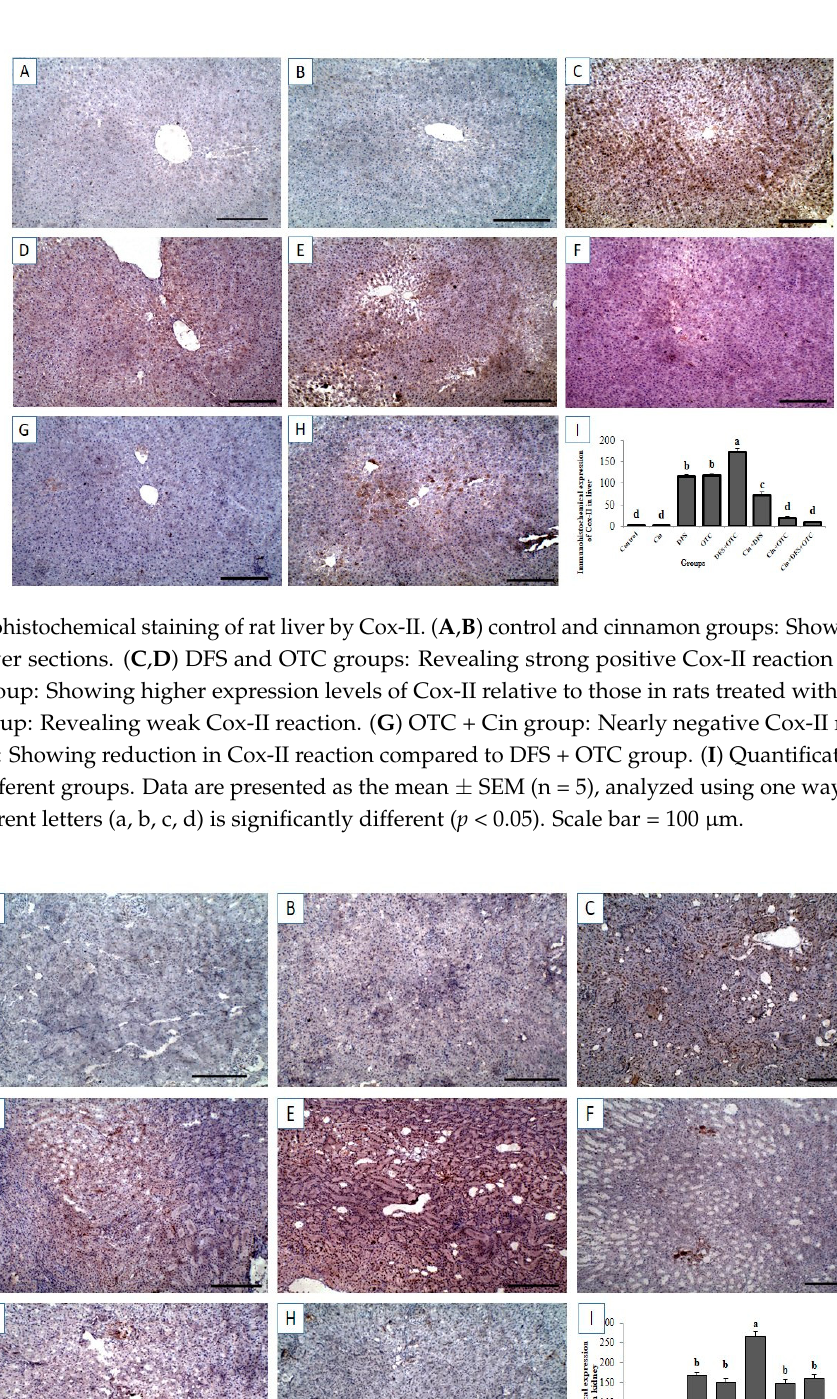
Figure 6. Immunohistochemical staining of rat liver by caspase-3. ( A , B ) control and cinnamon groups: Showing negative caspase-3 reaction in the liver sections. ( C , D ) DFS and OTC groups: Revealing strong positive caspase-3 reaction in the hepatocytes. ( E ) DFS + OTC group: Showing higher expression levels of caspase-3 relative to those in rats treated with DFS or OTC alone ( F ) DFS+ Cin group: Revealing weak caspase-3 reaction. ( G ) OTC + Cin group: strong caspase-3 positive reaction. ( H ) DFS + OTC + Cin group: Showing reduction in caspase-3 reaction compared to DFS + OTC group. ( I ) Quan- tification of caspase-3 in the liver tissues in different groups. Data are presented as the mean ± SEM (n = 5), analyzed using one way ANOVA and each bar carrying different letters (a, b, c, d) is significantly different ( p < 0.05). Scale bar = 100 µm.